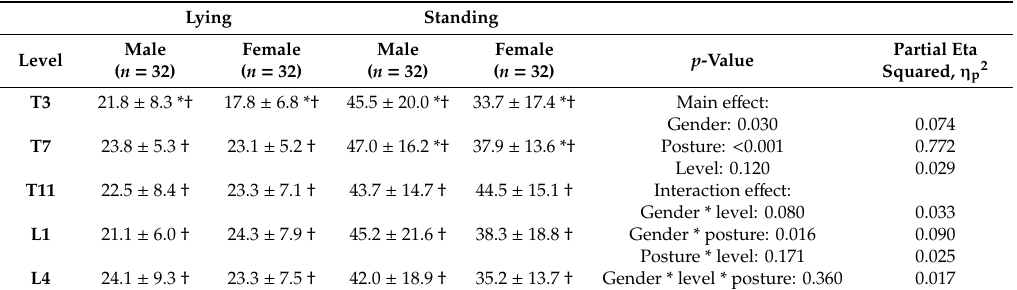
Table 2. The shear-wave elastography (SWE) sti ff ness in kPa (mean ± SD) ( n = 64). Lying Standing